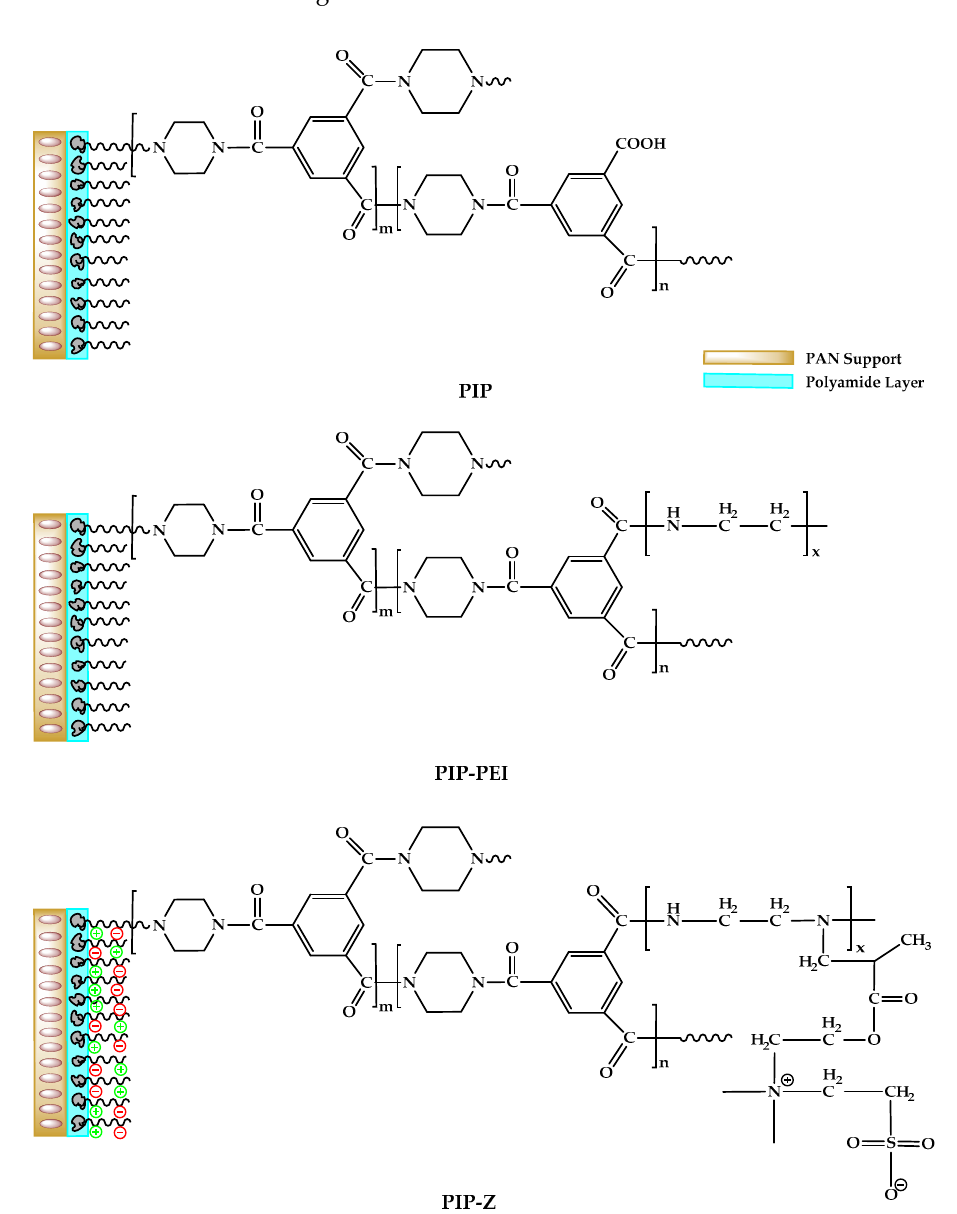
Figure 1. Chemical structure of the resultant membrane after second interfacial polymerization.